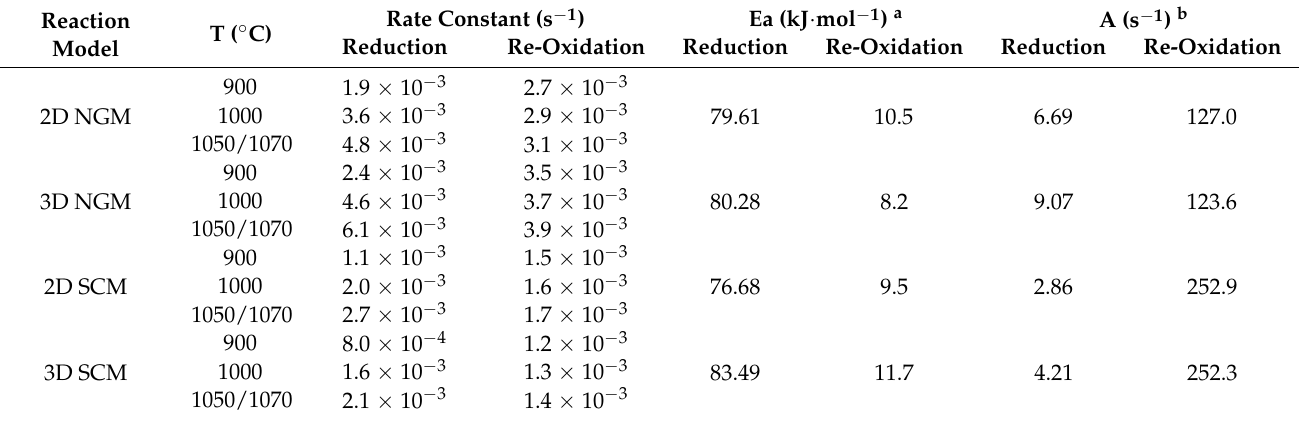
Table 1. Kinetic parameters obtained from various mechanistic functions for CH 4 -induced reduction and CO 2 -induced re-oxidation over CeO 2 oxygen carrier in a solar thermal